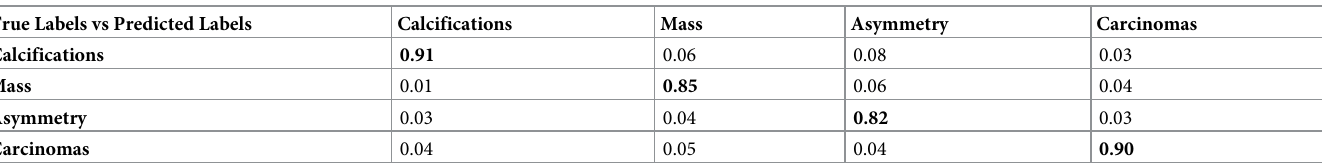
Table 1. Performance of the enhanced CNN model.